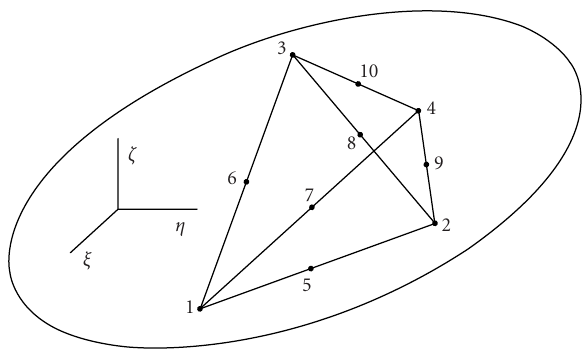
Figure 2.1. The rigid body system with the equivalent system of ten